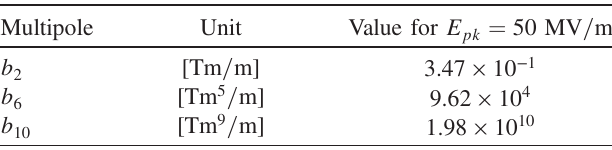
TABLE IV. Different multipoles of the four-vane cavity with r ¼ 30 mm and α ir